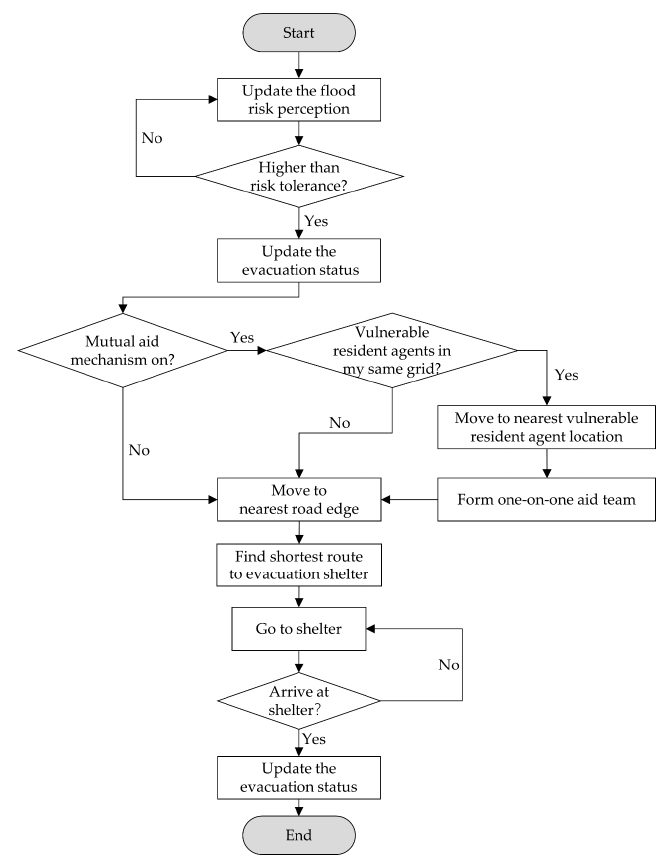
Figure 2. The decision-making process of resident agents.